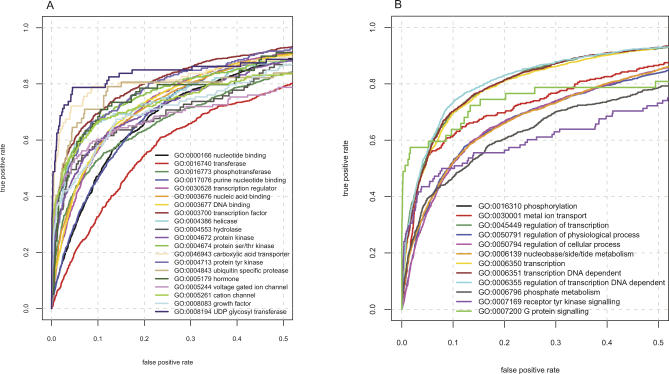
Receiver Operating Characteristics for Molecular Function (A) and Biological Process (B) ClassifiersThe ROC curve can be used to judge the classification sensitivities represent by the x-axis at different false positive rates represented on the y-axis.